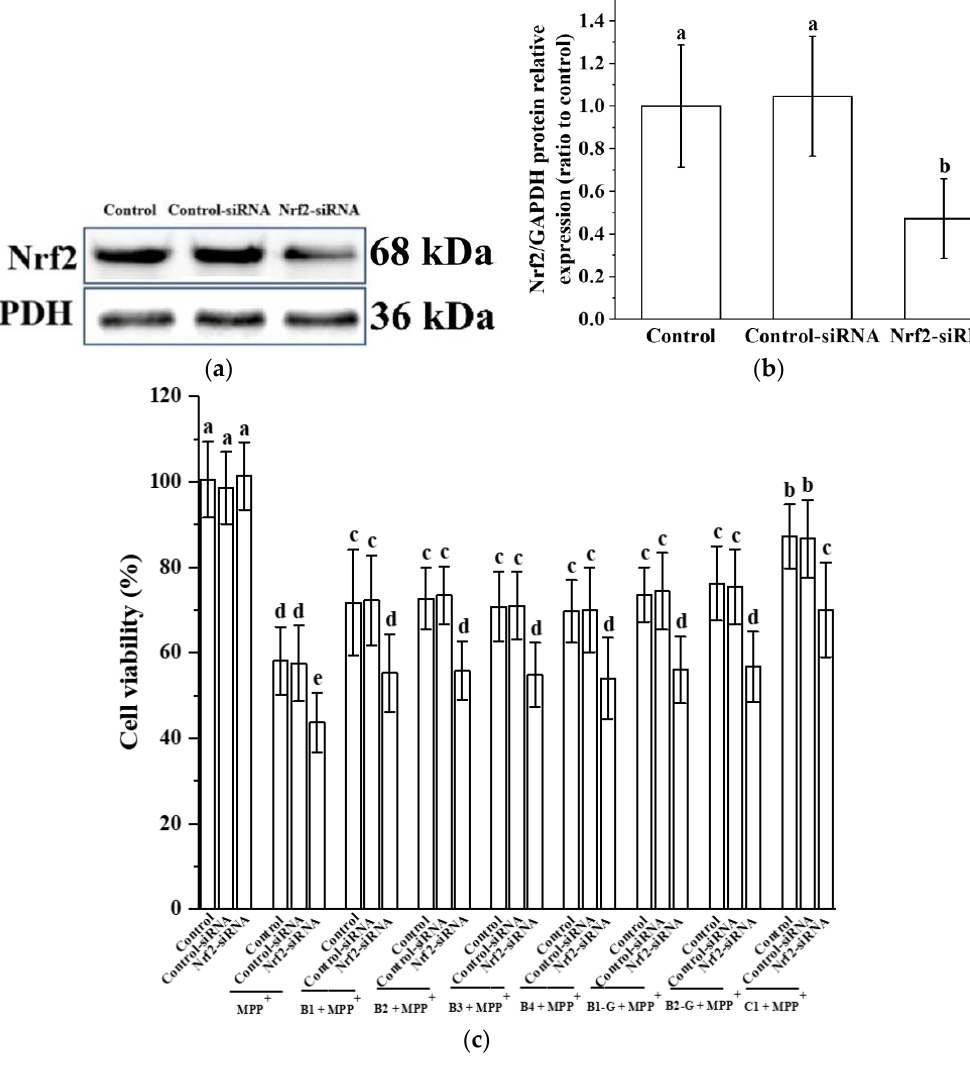
Figure 6. Verification of the effect of Nrf2 on the protective effect of different structural procyanidins in the PC12 cell PD model. ( a ) Knockout efficiency was detected by determination of Nrf2 protein expression using Western blotting. ( b ) Nrf2/GAPDH protein relative expression (ratio to control). ( c ) Cell viability. Data are shown as the mean ± SD. All experiments were conducted three times.